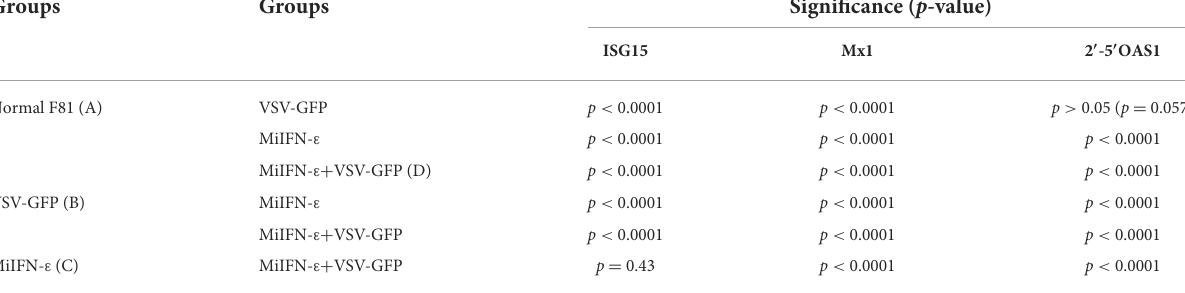
TABLE 2 Changes in interferon-stimulated genes expression levels between different treatment groups during the antiviral activity of mink interferon (MiIFN)- ε . Groups